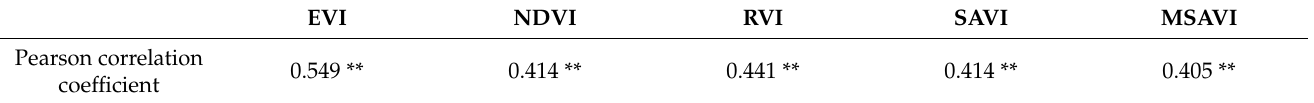
Table 6. Correlation coefficient matrix between DVI and other vegetation indices.